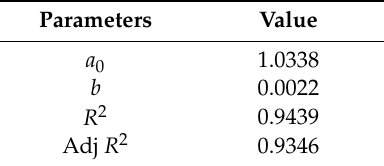
Table 3. Fitting parameters and coe ffi cients of determination for the fitting of the data of Figure 1, using Equation (10).